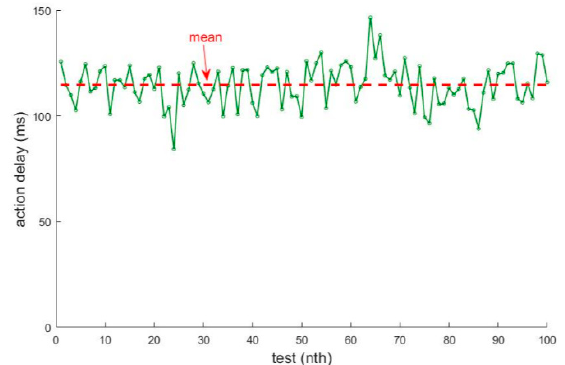
Figure 9. Curve of load data accessed on grid side.